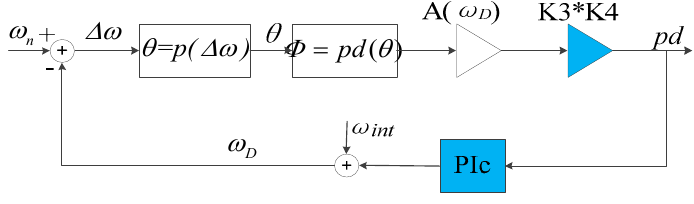
Figure 12. Order ‐ reduction model of PLL. Figure 12. Order-reduction model of PLL.